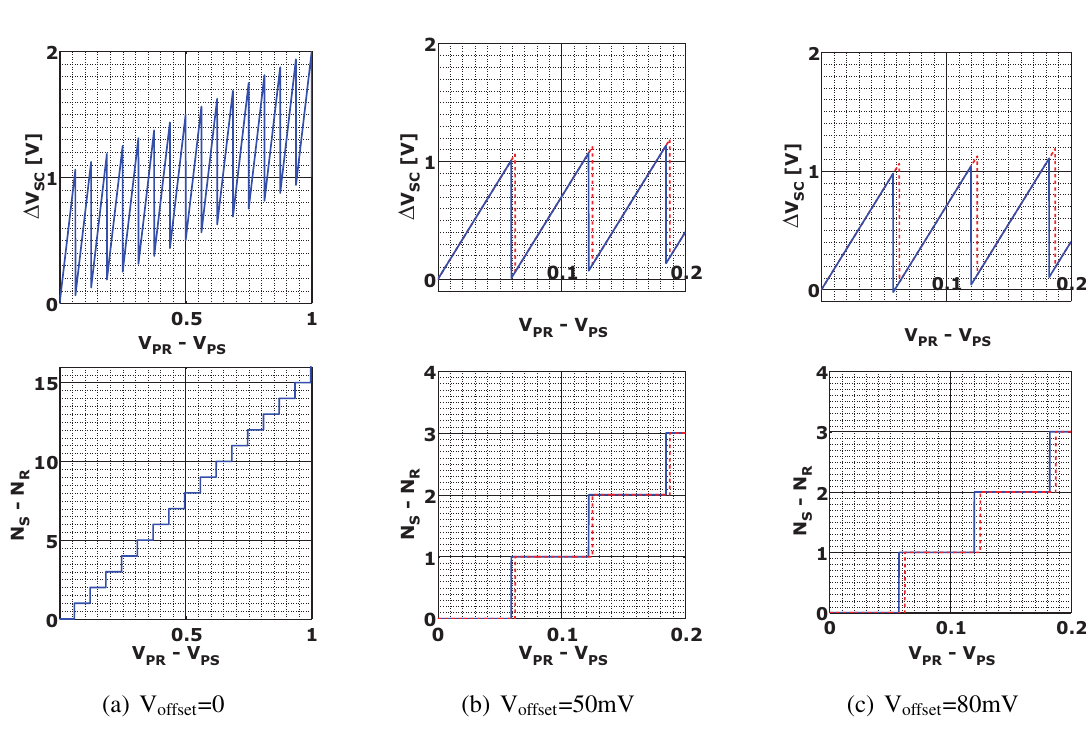
Characteristics of Integrated Outputs with Comparator Offset for M = 17 (Red dot-line: V = offset